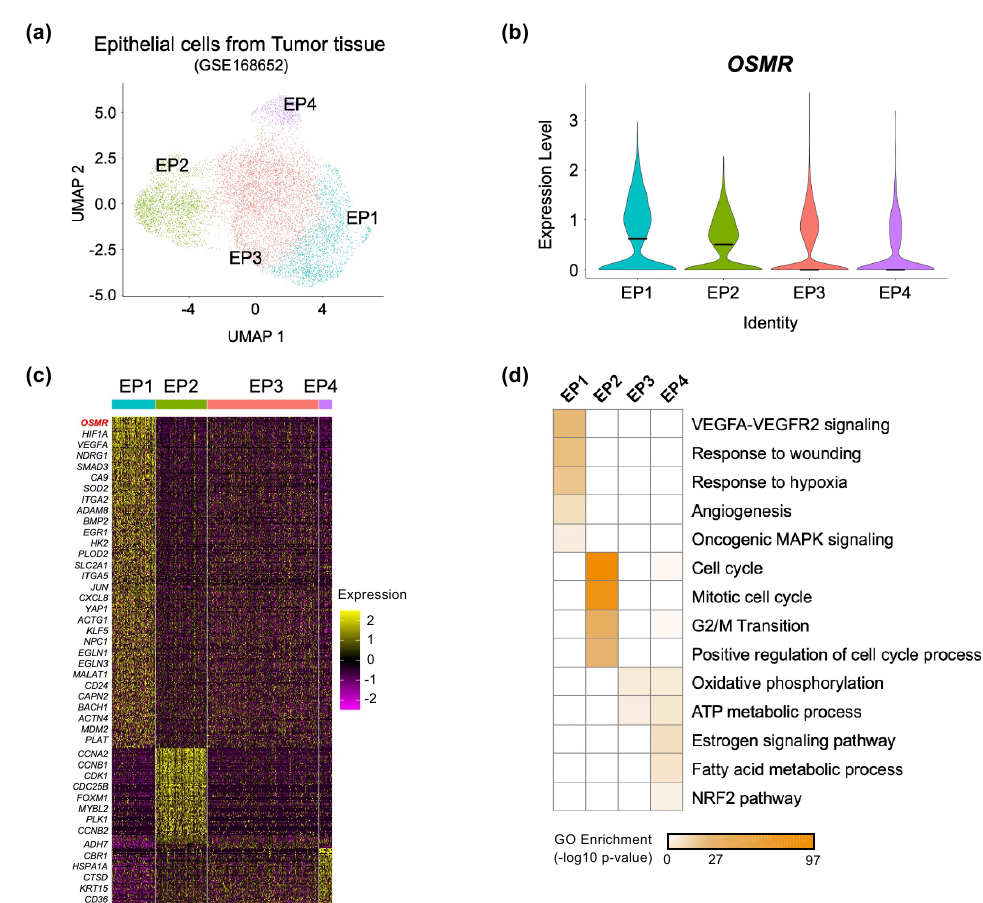
Figure 2. Analysis of OSMR expression levels for epithelial cell heterogeneity. ( a ) UMAP projection of epithelial cells that were subgrouped by re-clustering analysis of cervix tumor tissue scRNA-seq data. ( b ) Violin plot displaying OSMR expression in all epithelial cell clusters in cervix tumor tissue. ( c ) Heatmap shows the expression patterns of epithelial cell markers; log2FC > 0.3; adj. p < 0.05. ( d ) Heatmap showing the p -value significance of GO term enrichment for marker genes in each